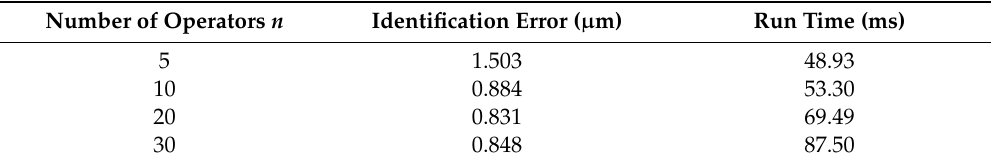
Table 1. The relationship between the number of operators n , identification error, and run time.